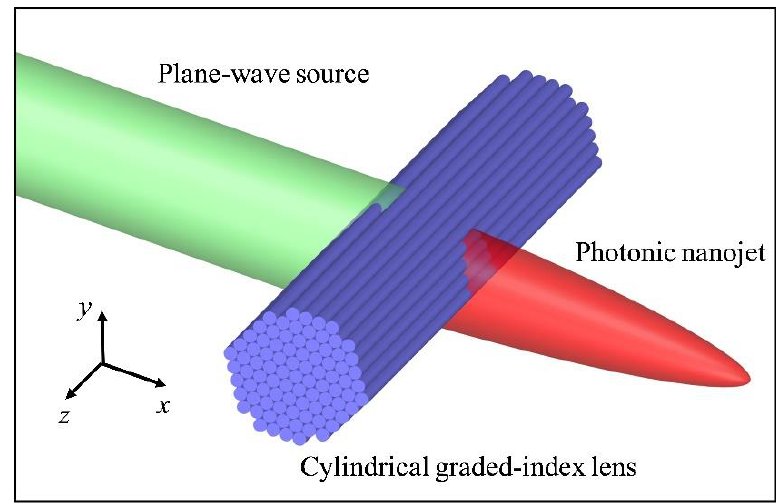
Figure 1. Schematic diagram of the cylindrical graded-index lens for photonic nanojet.